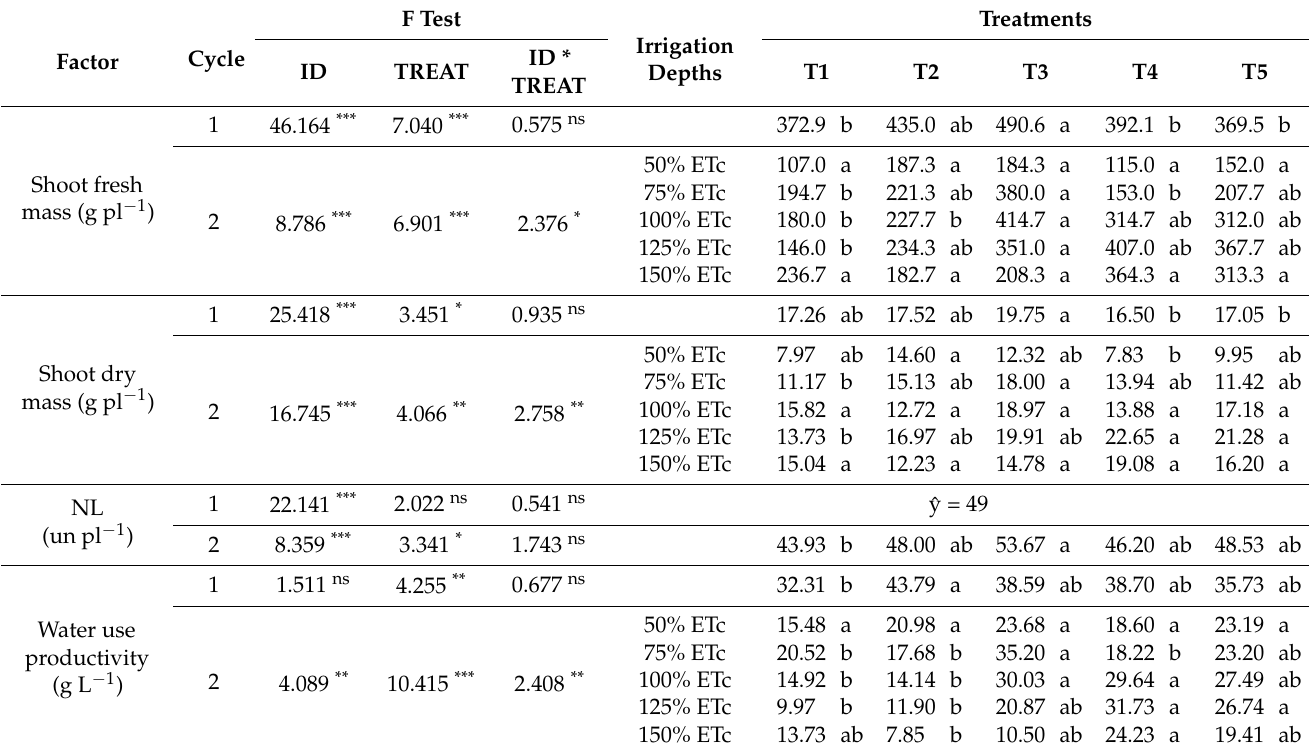
Table 3. Mean values of shoot fresh mass, shoot dry mass, number of leaves (NL) and water-use